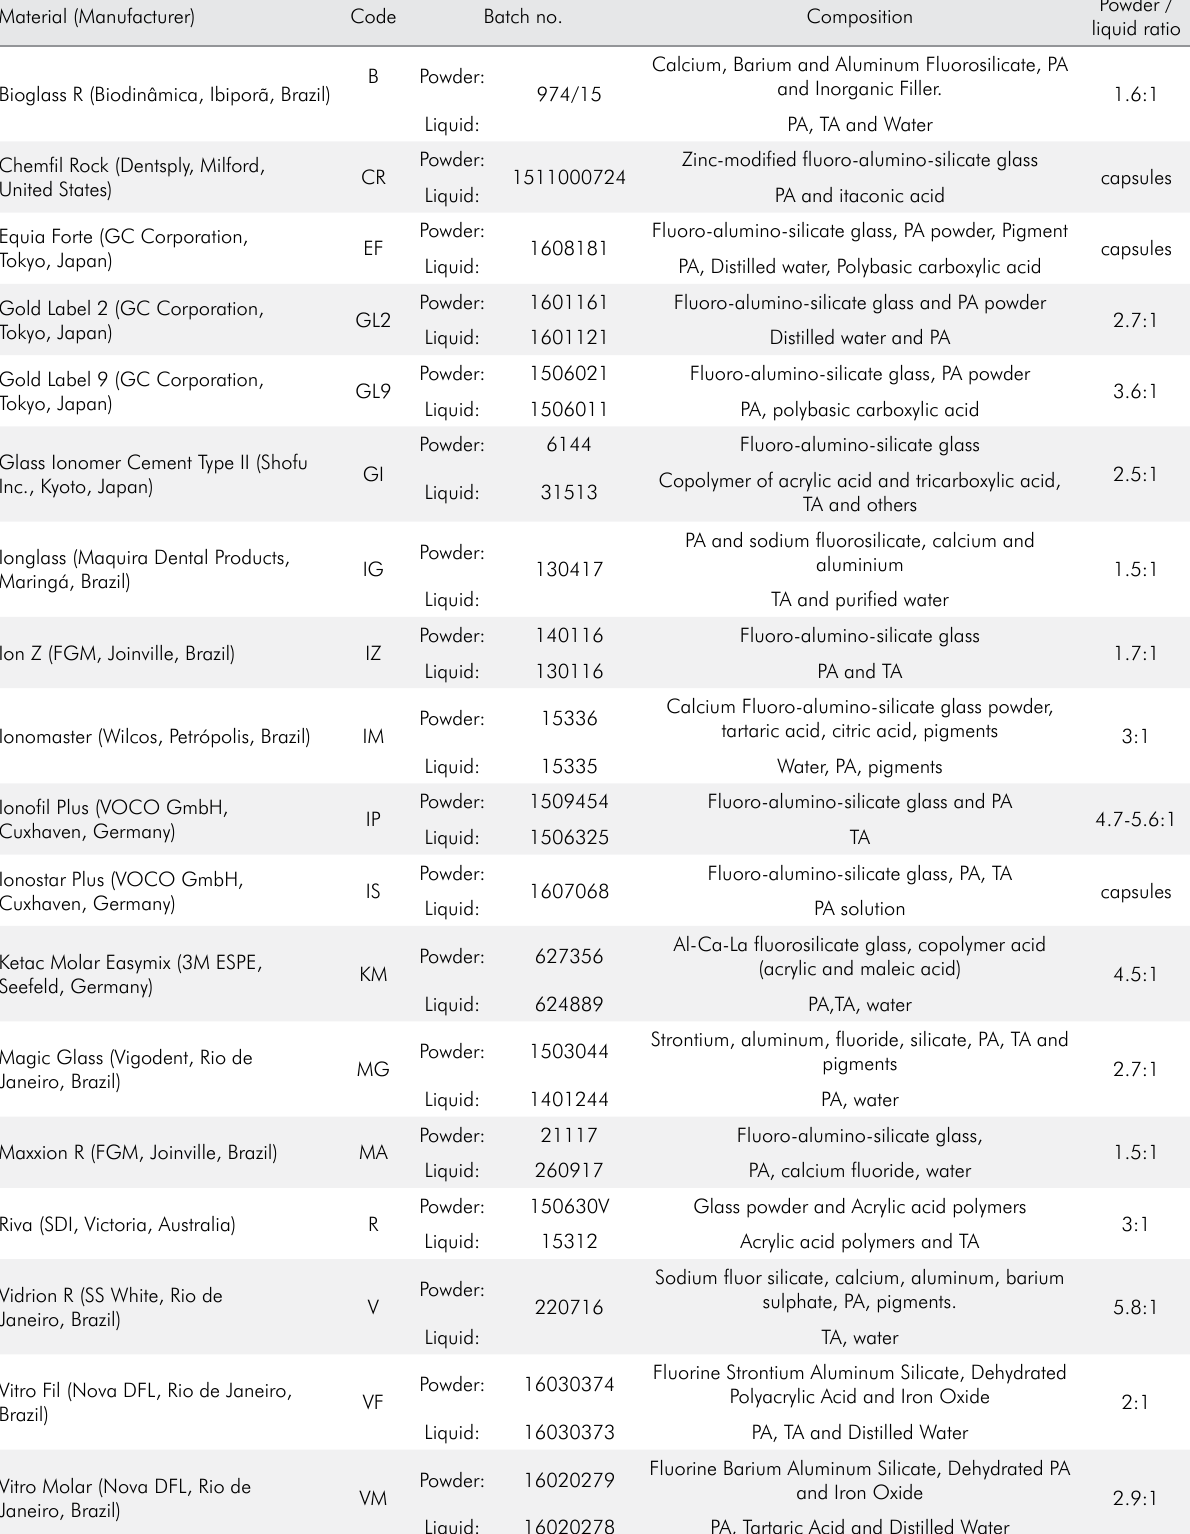
Table 1. Brands, code, batch numbers, composition and powder/liquid ratio of conventional restorative glass-ionomer cements tested Material